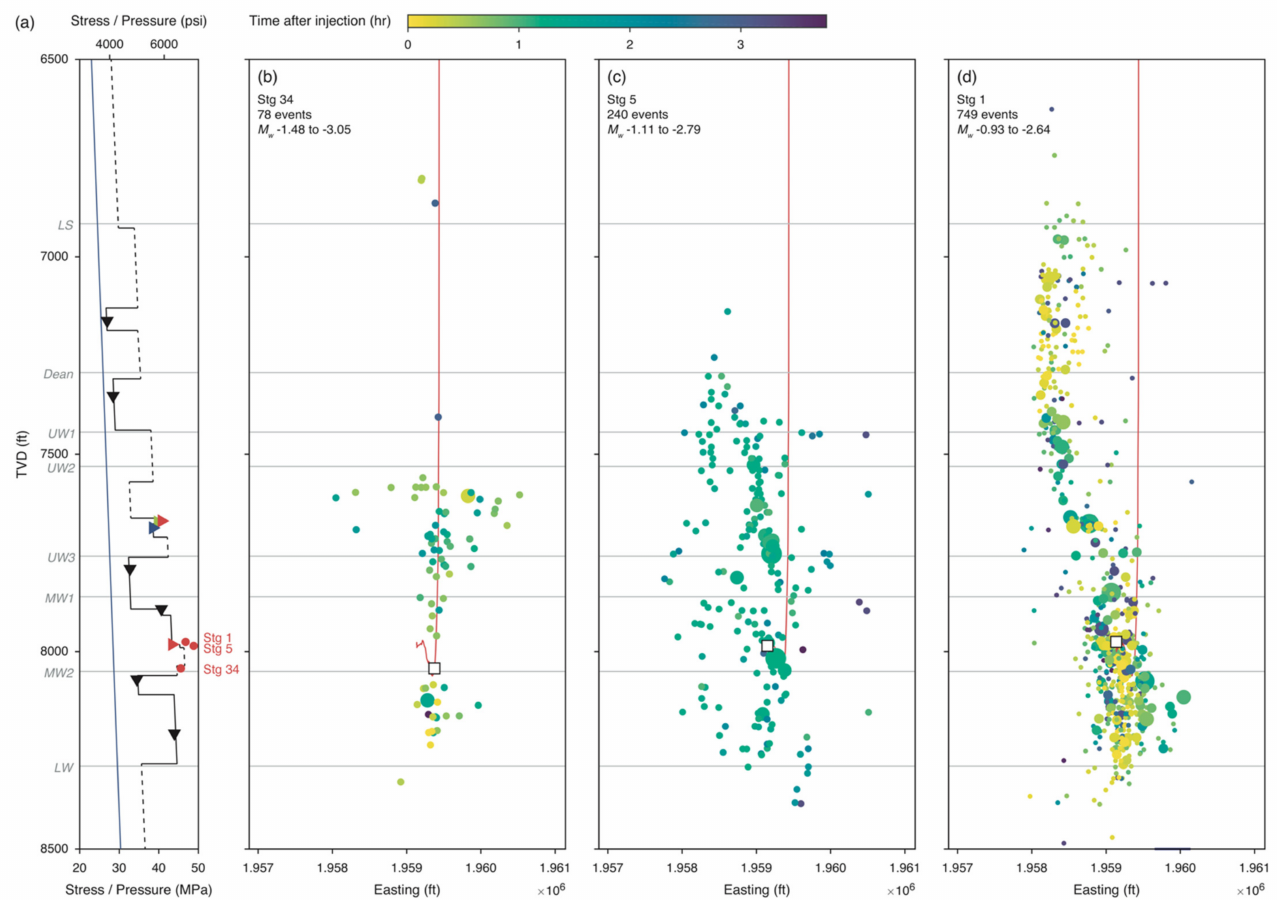
Figure 10. ( a ) Interpreted stress profile based on stratigraphically shifted stress measurements. ISIP values for well 6SM stages 1, 5, and 34 are plotted as small red triangles. ( b – d ) Gun barrel views of microseismicity from stages 1, 5, and 34. Events are colored by time after injection (Figure 10). White stars indicate the location of each